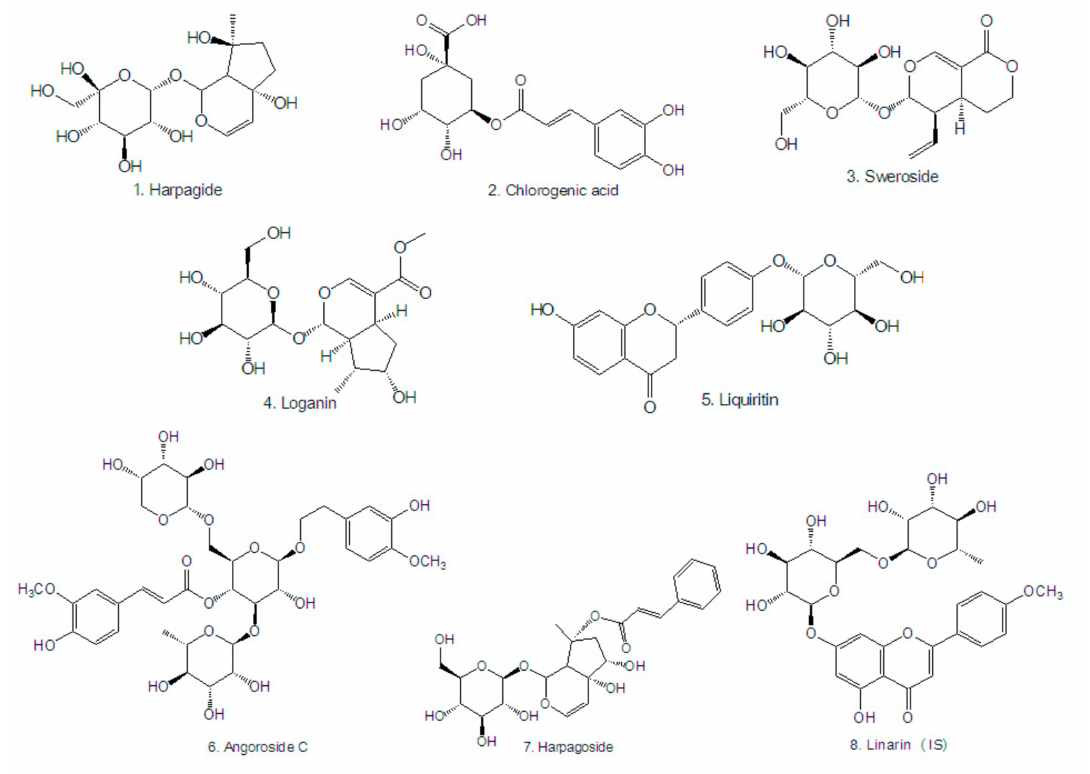
Figure 3. Chemical structures of the analytes and